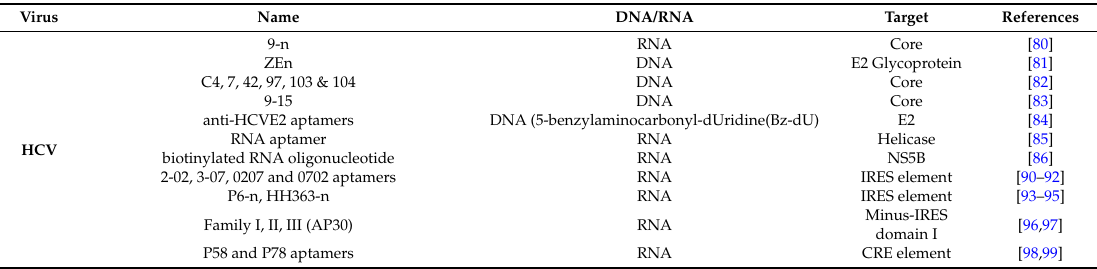
Table 4. Summary data on the aptamers selected against HCV discussed